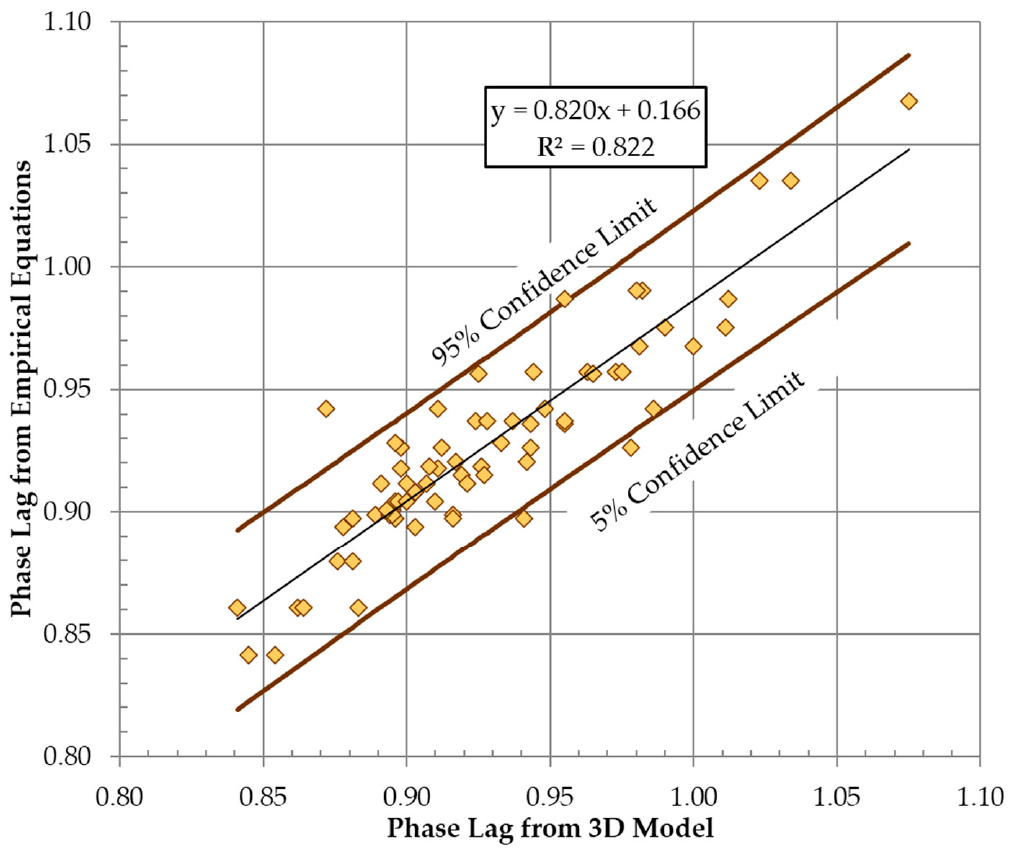
Figure 52. Comparison of shear stress phase lags computed by Equations (24)–(26) with phase lags simulated by the 3D